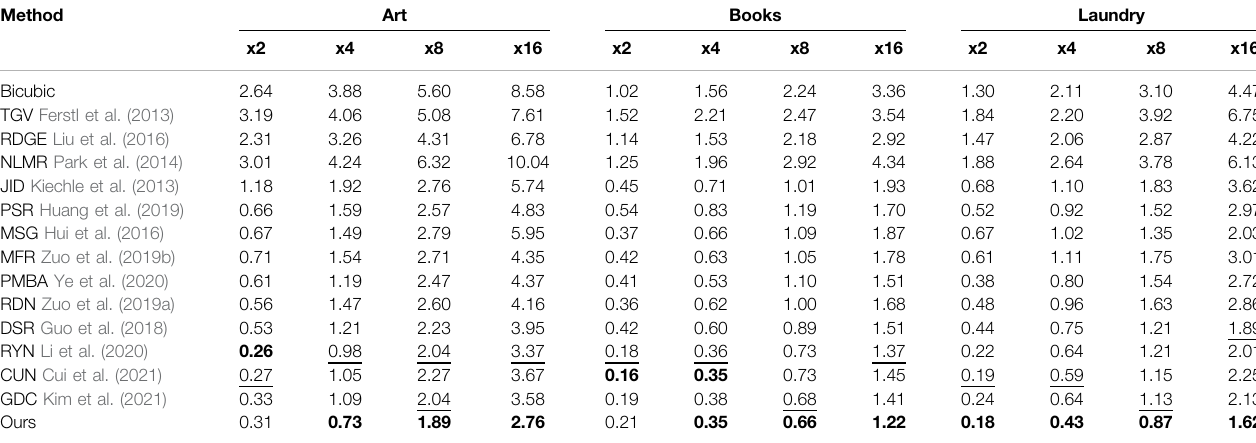
TABLE 1 | Quantitative comparisons on “ art. ” “ books ” and “ laundry ” from the noise-free middlebury dataset in terms of RMSE values for different scaling factors. Method Art